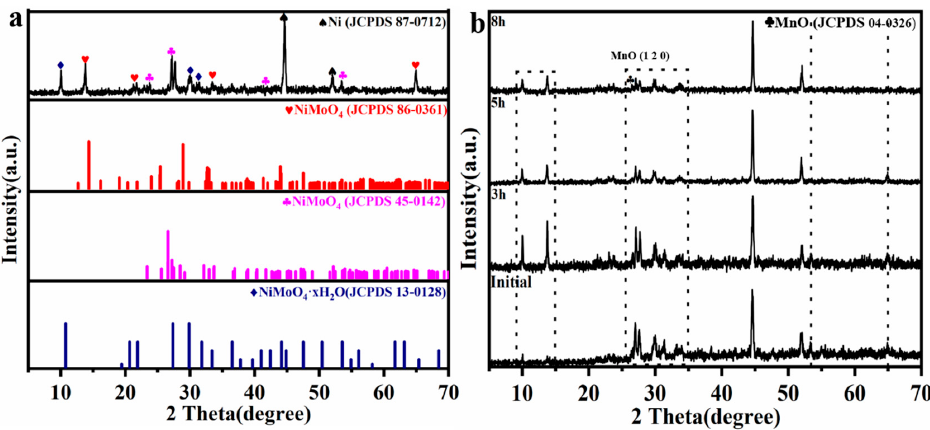
Figure 2. XRD patterns of ( a ) the precursors NiMoO 4 /NF and ( b ) Mn-doped-NiMoO 4 /NF with different reaction times (3 h, 5 h, 8 h).